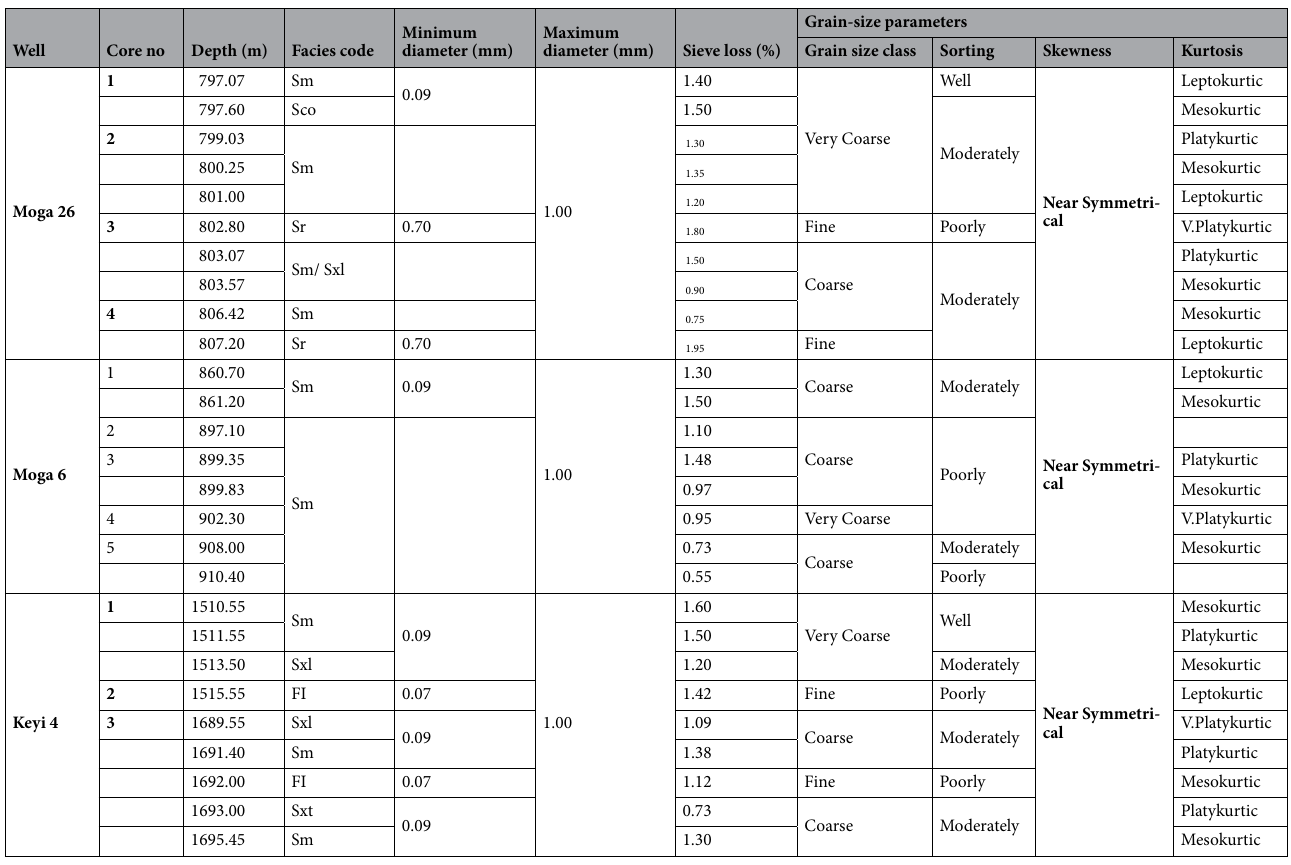
Table 4. Statistical data of the analyzed core